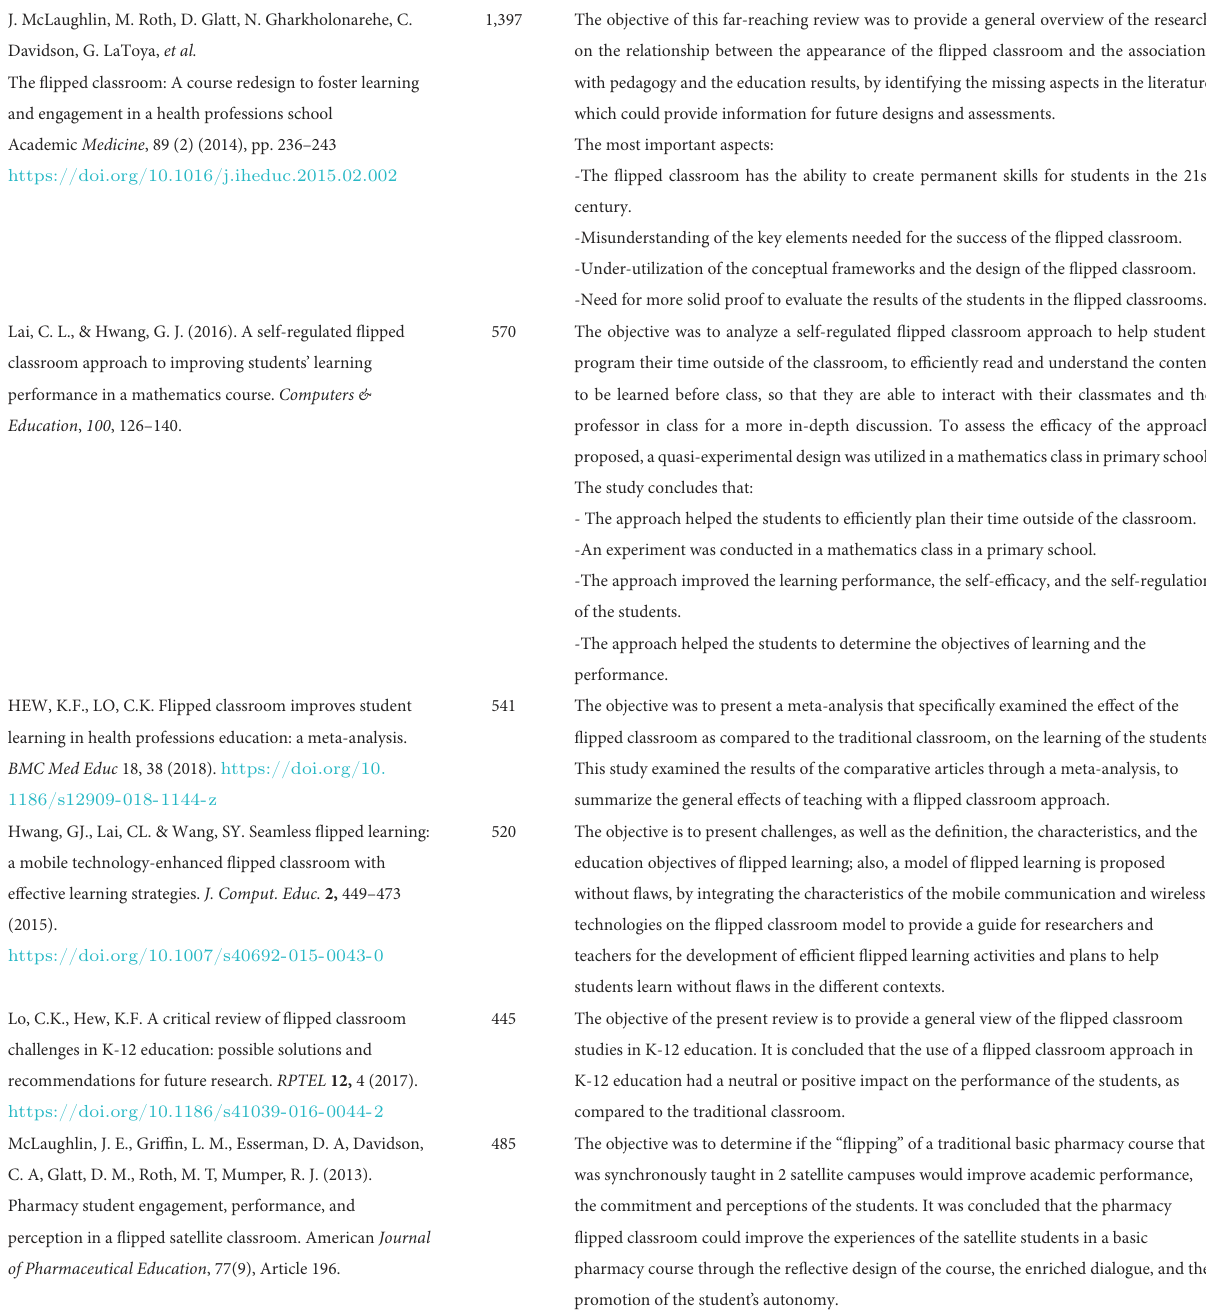
TABLE 5 Analysis of the most-cited FC